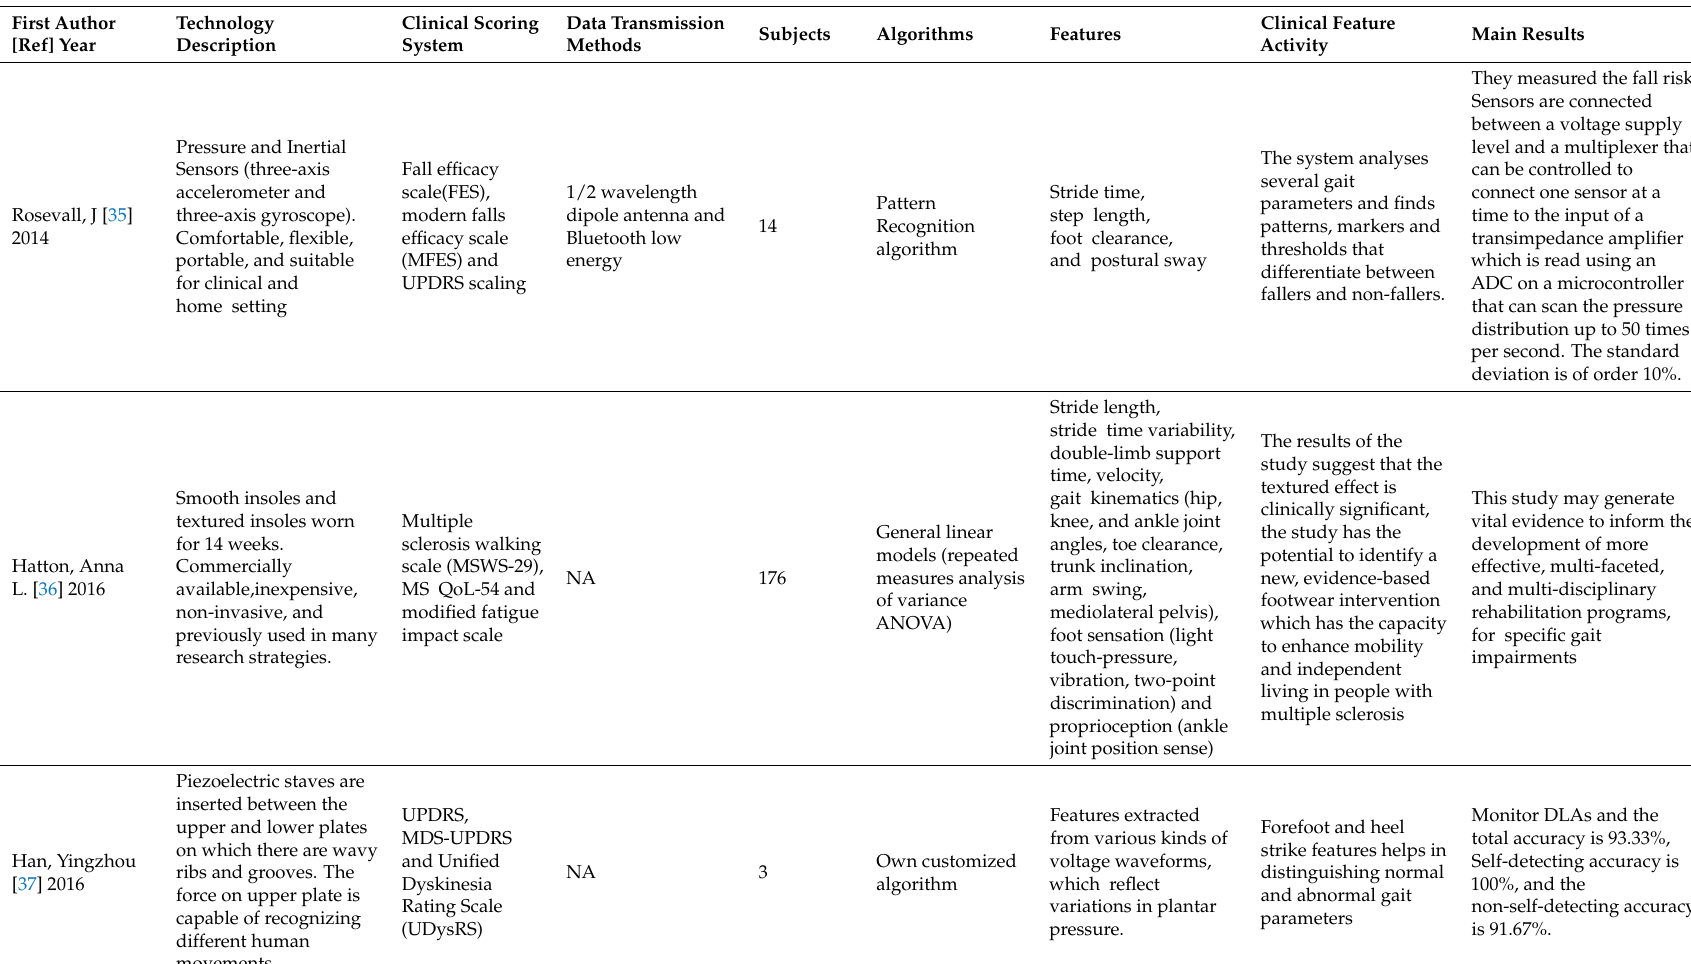
Table 7. Wearable insoles models for diagnosis, monitoring, and